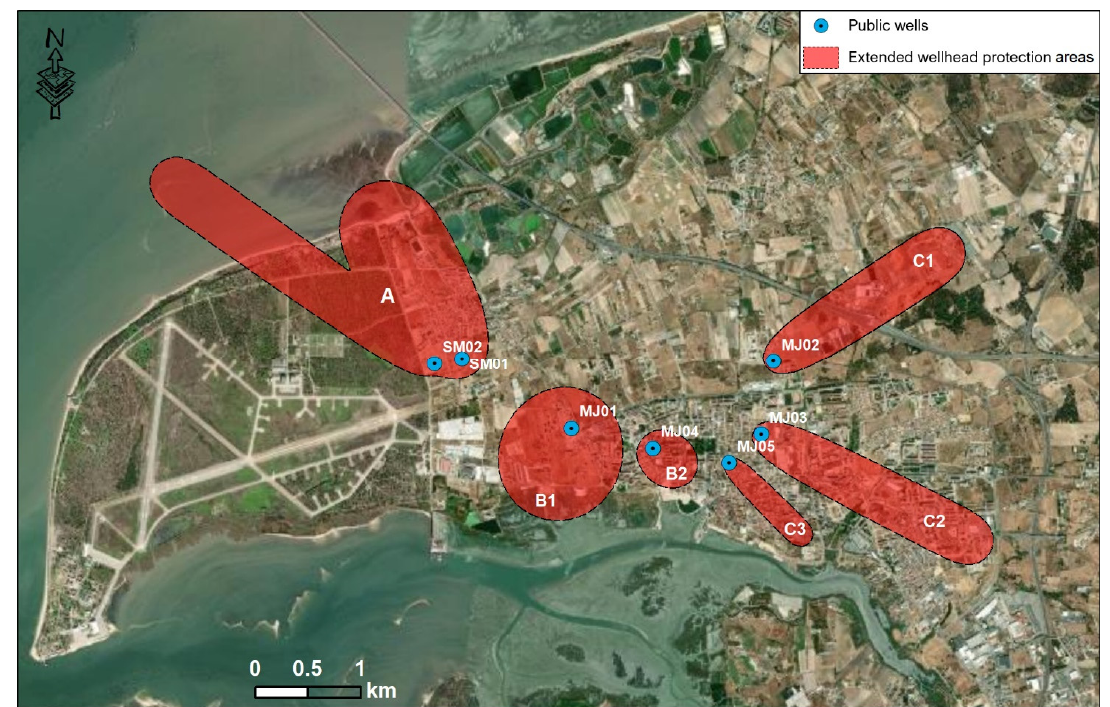
Figure 10. Extended wellhead protection zones delimited by the Wyssling method.